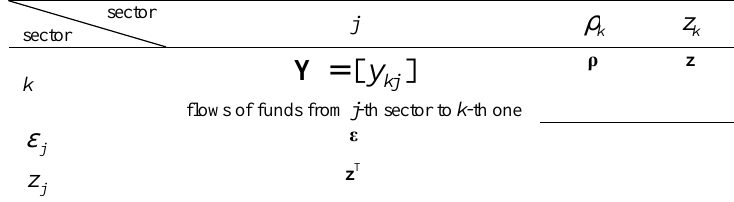
Table 2. Financial input-output table (based on the asset oriented